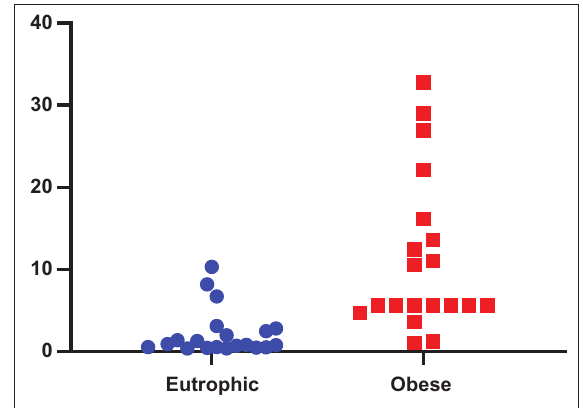
Figure-1: Analysis of the homeostatic model assessment 2 or non-linear between normal weight and obese, showing significantly higher levels in obese dogs than normal weight (p < 0.05).